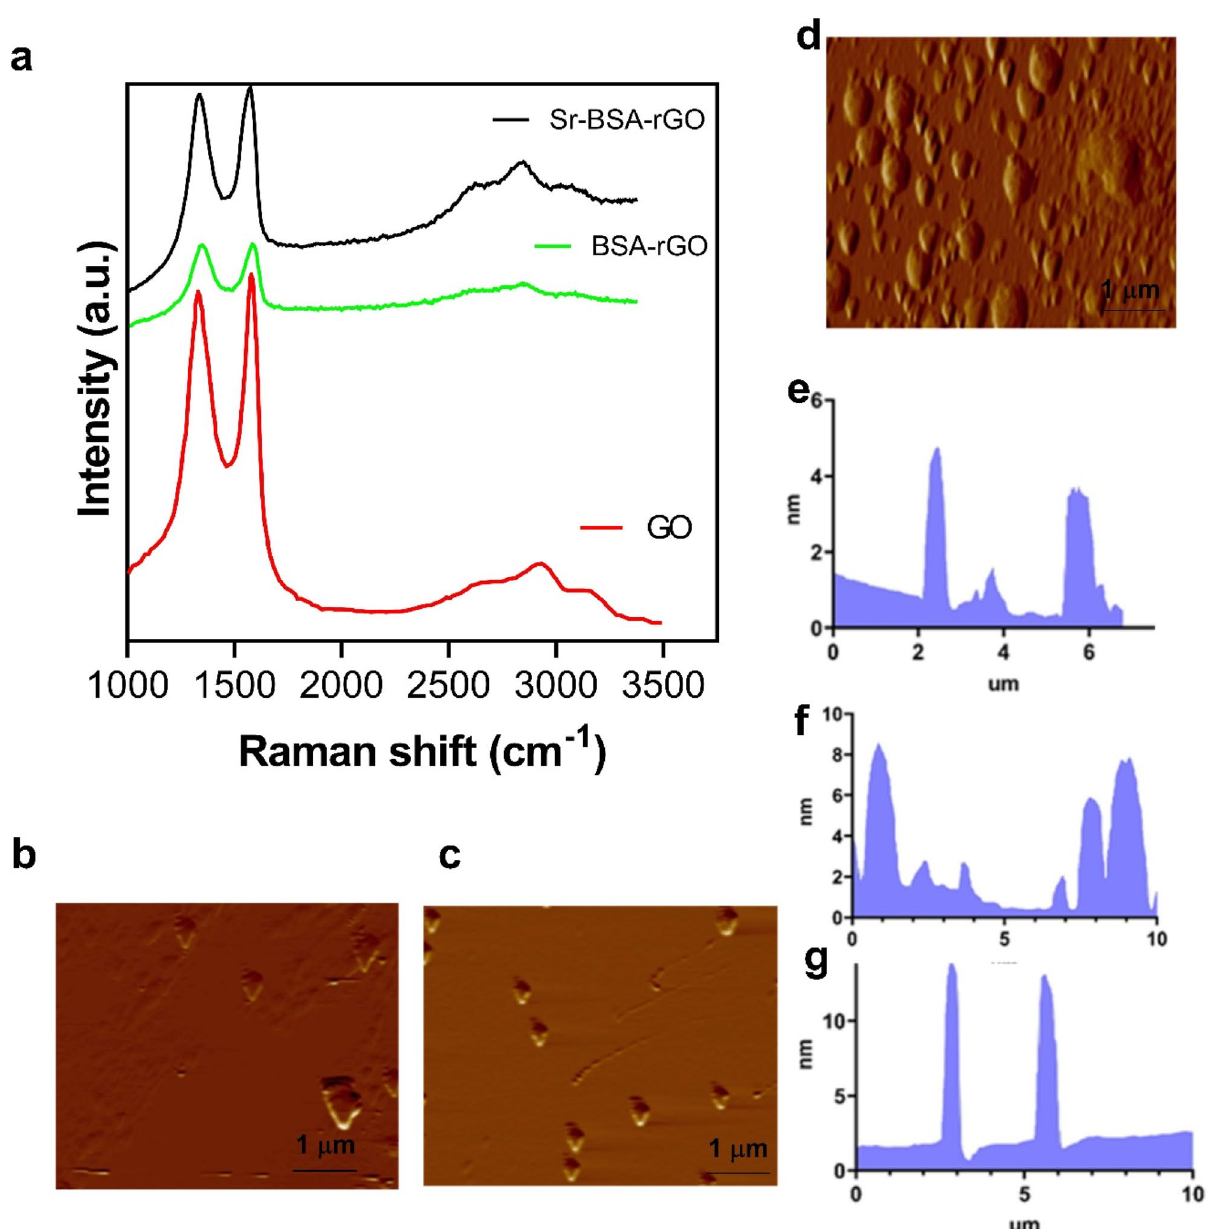
Figure 3. Structural and morphology of nanosheets. ( a ) Raman spectrum of GO, BSA-rGO and Sr-BSA-rGO nanosheets. ( b–d ) AFM images of GO, BSA-rGO, Sr-BSA-rGO nanosheets respectively. ( e–g ) The thickness profile of GO, BSA-rGO, and Sr-BSA-rGO